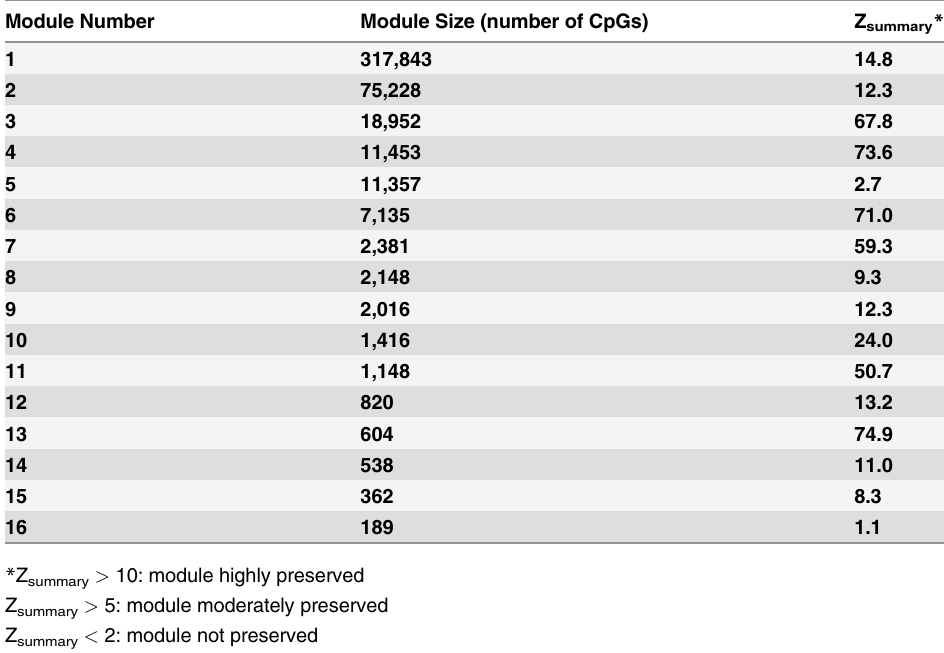
Table 1. Module preservation between data